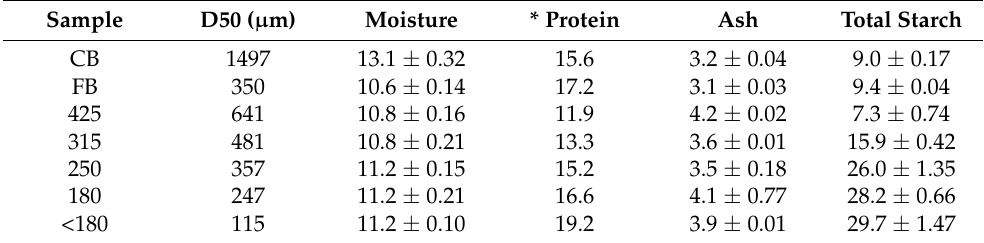
Table 1. Chemical composition of bran fractions (g/100 db). Data are mean ± stdev.